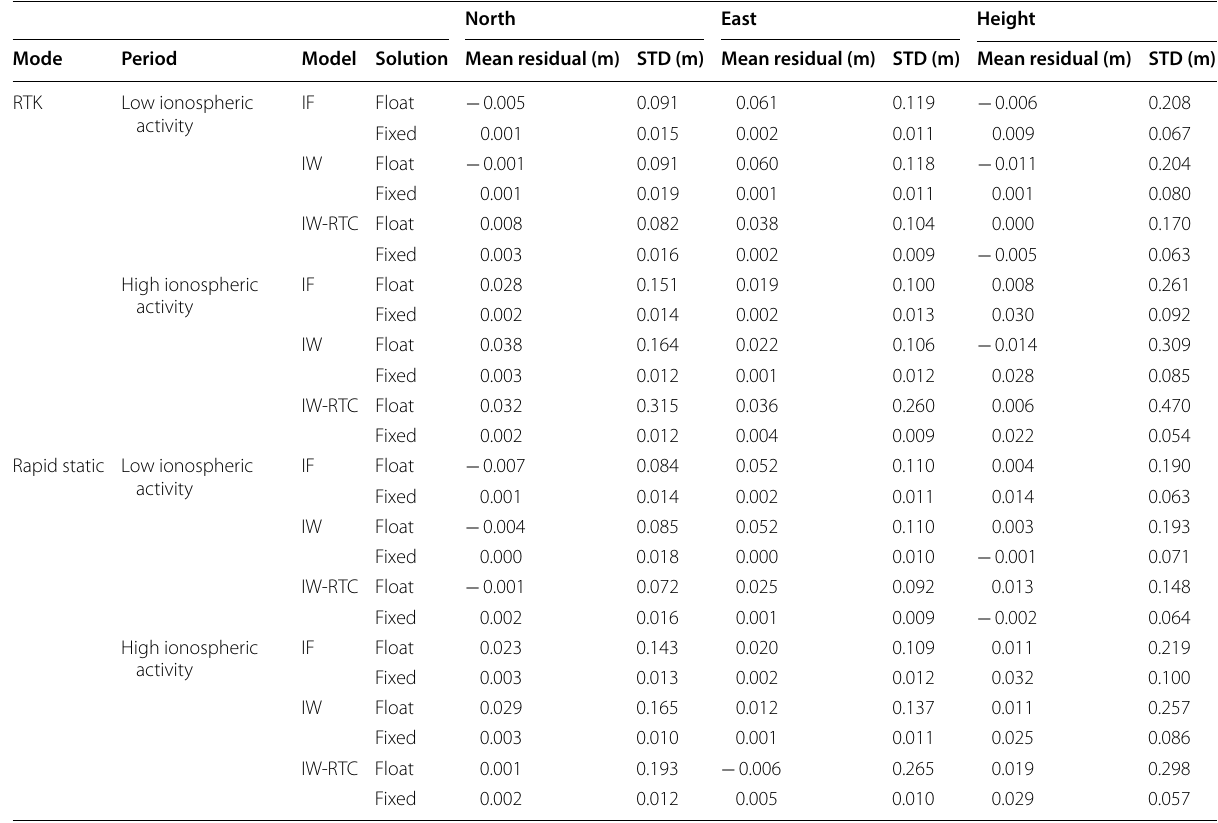
Table 3 Empirical coordinate statistics of float and fixed solution obtained in RTK and rapid static modes: STD and mean coordinate residuals